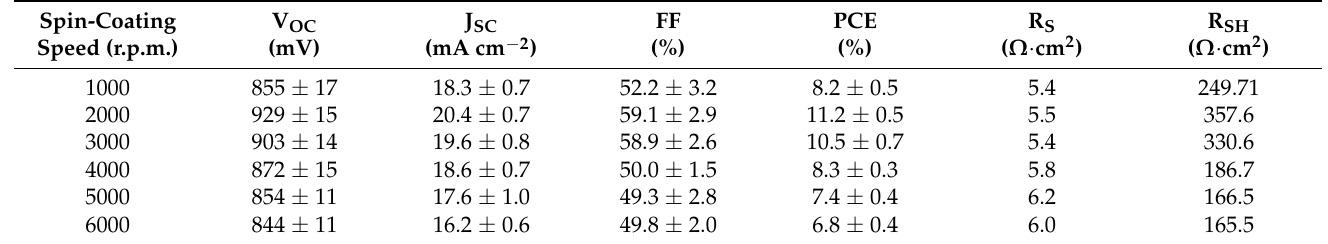
Table 1. Statistics PV parameters of devices processed from PbI 2 films with different spin-coating speeds. Spin-Coating Speed (r.p.m.)